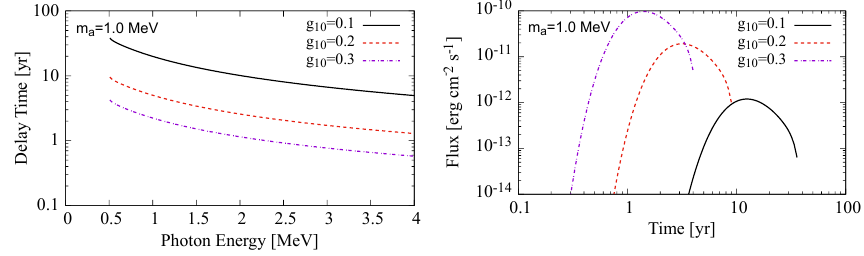
after ignition. When ALPs are heavier than ∼ 5 MeV, L a is suppressed. This is because